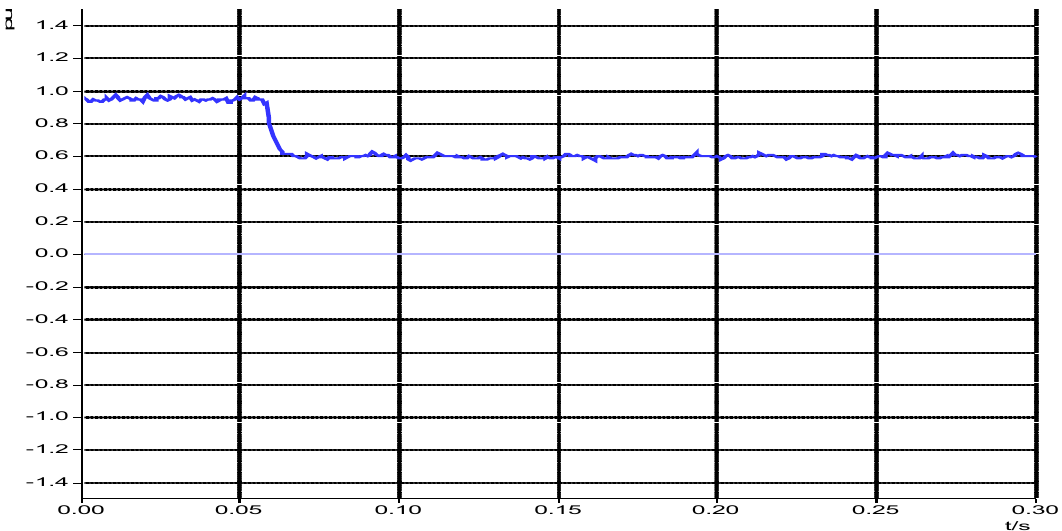
Figure 23. Voltage and current in the positive sequence (POS).